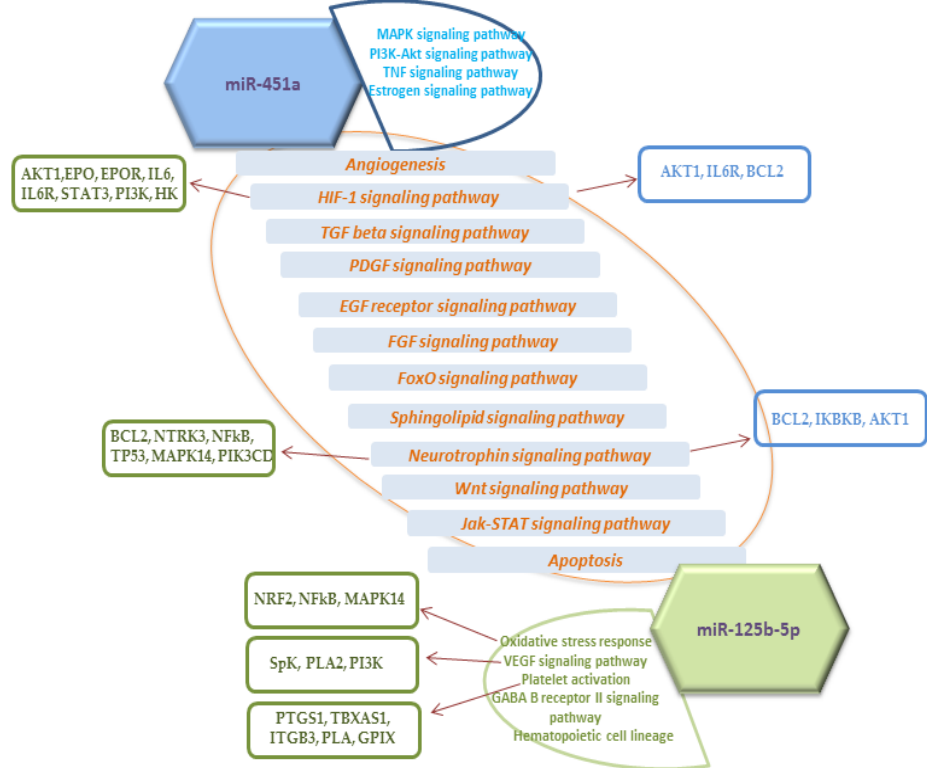
Figure 4. Signaling pathway potentially regulated by studied miRNAs ( p -value ≤ 0.05). Pathways included within the oval are common to miR-125b-5p and miR-451a. Lists of signaling pathways next to the figures with the name of miRNA are specific to the miRNAs. Target genes regulated by these miRNAs and participating in the corresponding signaling pathways are indicated in blocks with arrows. The color of the blocks corresponds to the color of the figures with the name of the miRNA. Names of signaling pathways : hypoxia’s response via